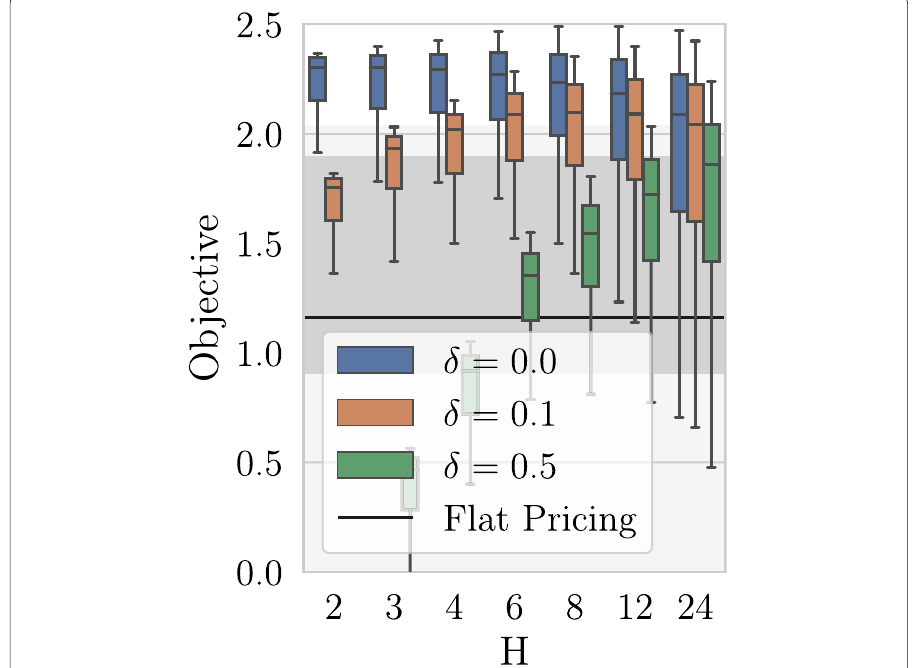
Fig. 4 Optimal objective function values subject to simultaneous parameter variation